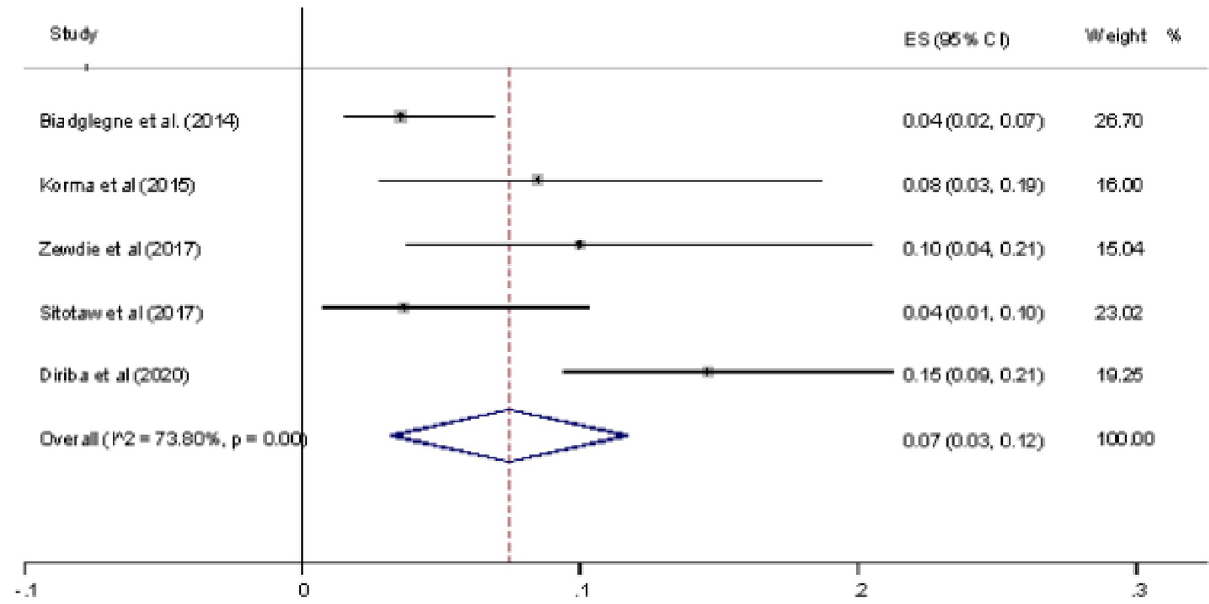
Fig 3. Forest plot showing the prevalence of INH among the total sample.